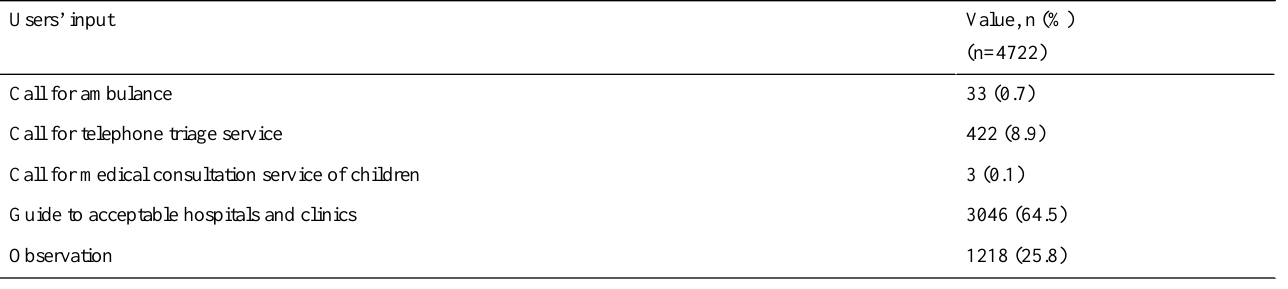
Table 3. Clinical